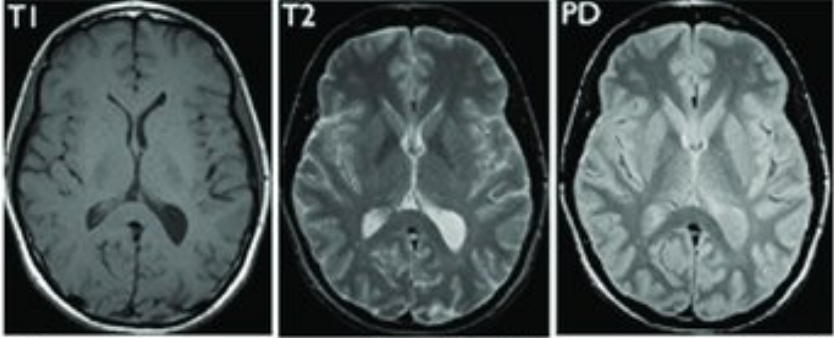
Figure 4. Normal brain images.